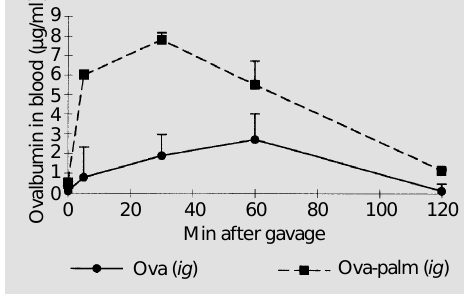
Figure 1 - Failure to induce oral tolerance with Ova-palmitate conjugates. B6D2F1 mice were pretreated with 20 mg of Ova, Ova-palm or saline (in 0.3 ml), ig , 1 week before being immunized with 10 µg of Ova or Ova-palm in Al(OH) 3 , ip . Two weeks later, mice were submitted to the same protocol as a booster, but without Al(OH) 3 . Mice were bled one week after secondary im- munization. Anti-Ova antibodies were detected by ELISA. Data are reported as a score (ELISA*), which represents the mean ± SEM (N = 4-6) of the sums of absorbance values from serum dilutions of 1/40 to 1/5120. Figure 2 - Kinetics of antigen ap- pearance in blood after intragas- tric administration. B6D2F1 mice were treated intragastri- cally with 20 mg of Ova or Ova- palm (in 0.3 ml saline). Animals were bled at several time inter- vals. Data detected by “sand- wich” ELISA represent the mean ± SEM (N = 8-9) of anti- gen concentration in